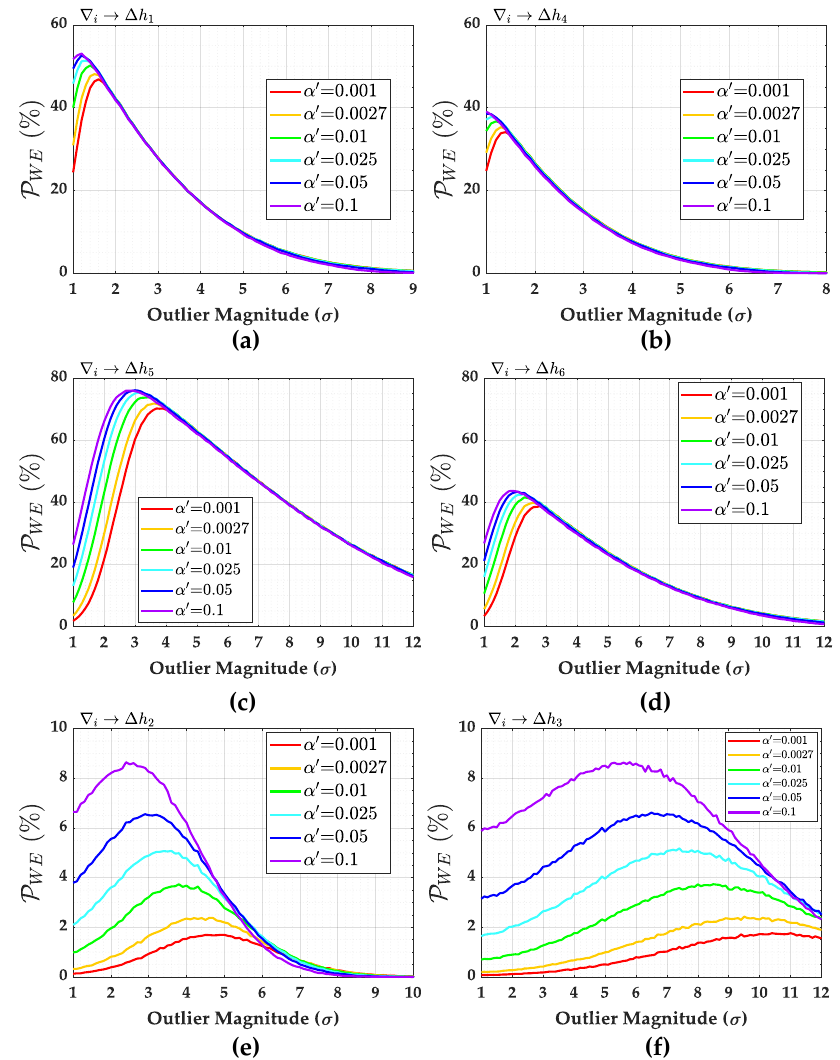
Figure 17. Probability of wrong exclusion ( P WE ) for network ( b ). ( a ) P WE for ∆ h 1 . ( b ) P WE for ∆ h 4 . ( c